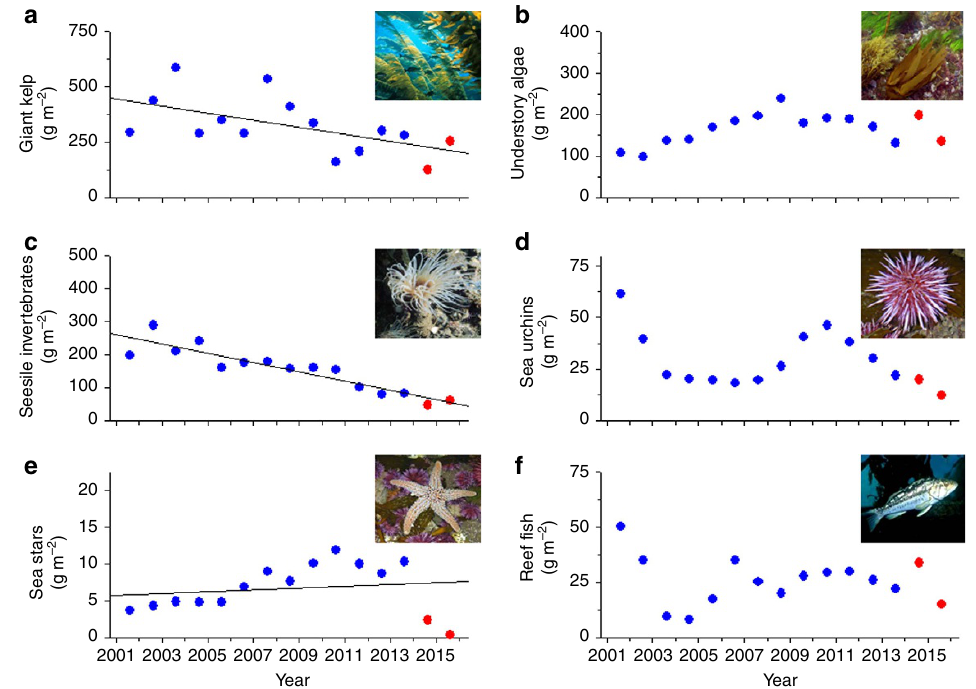
Figure 3 | Ecosystem responses to extreme warming in the Santa Barbara Channel. Temporal trends in the biomass of the major groups of kelp forest primary producers and consumers prior to (2001–2013, blue) and during (2014–2015, red) the anomalous warm period. ( a ) giant kelp, ( b ) understory algae, ( c ) sessile suspension feeding invertebrates, ( d ) sea urchins, ( e ) sea stars and ( f ) reef fish. Biomass values are annual means measured in summer averaged over nine sites and are in units of decalcified dry mass, except reef fish which are in units of dry mass. Regression lines are provided for cases where year contributed to a significant model (Table Table 1 | Variation in ecological responses attributed to oceanographic anomalies. Ecological response